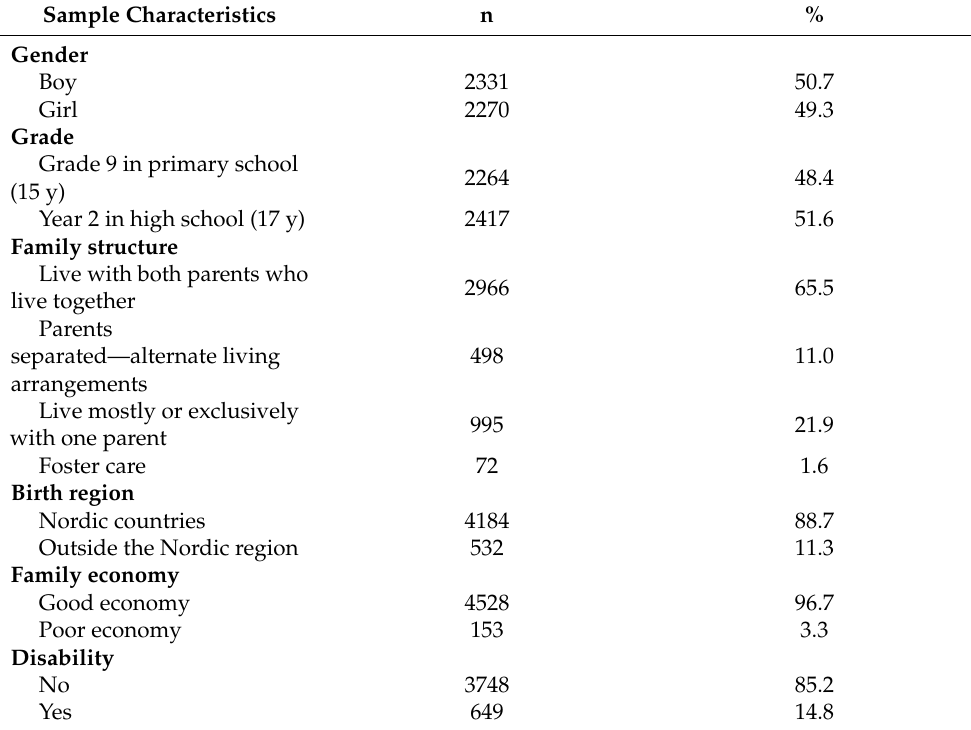
Table 1. Socio-demographic characteristics of